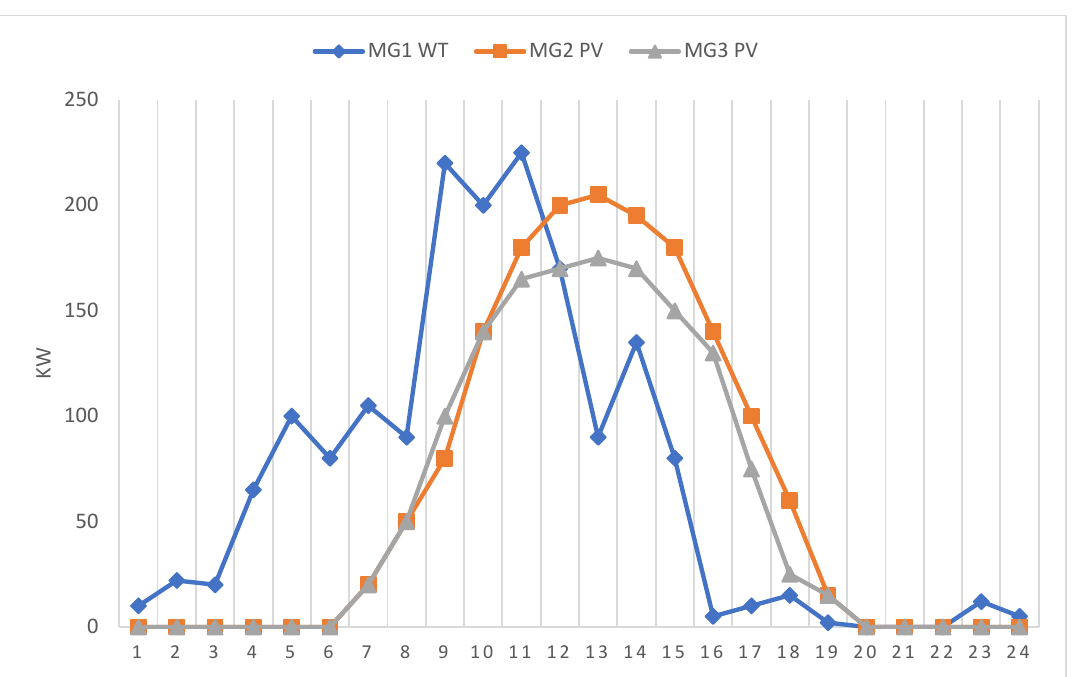
Figure 5. Production power of renewable generators in each microgrid. Table 1 shows the specifications of production units in each microgrid. Table 1. Specifications of production units in each microgrid.